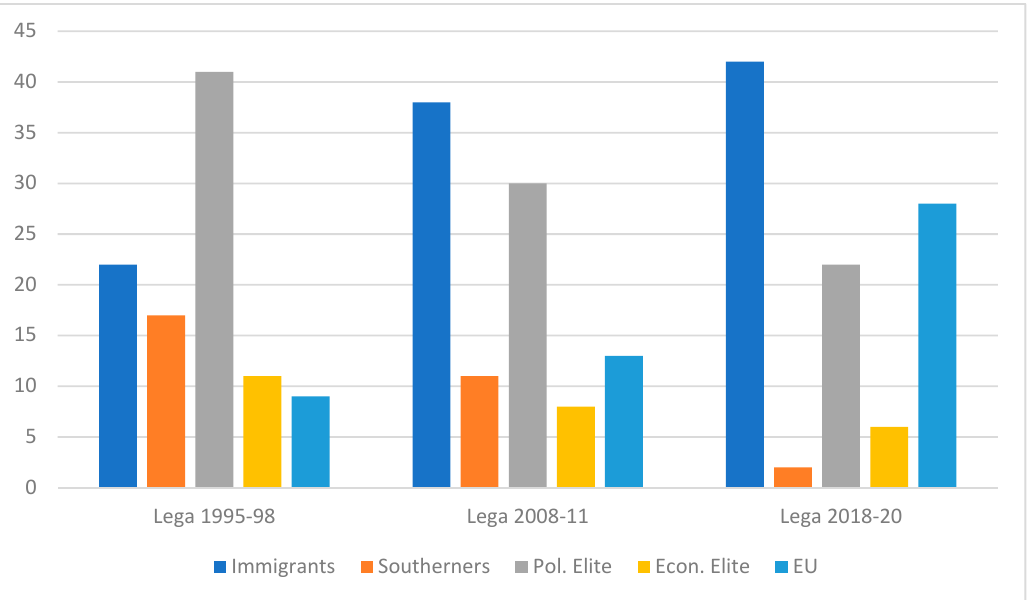
Figure 1. Defining the ‘Other’—the Lega’s framing of the threats to the ‘people’ (in %). It is worth noting that, throughout its transformation from a regionalist actor to a right- The other two components of the Lega’s strategy of demarcating the ‘people’ were a wing nationalist opposition party, the Lega kept the anti-immigrant rhetoric as a constant fea- persistent anti-immigrant rhetoric and an opposition directed at the ‘Southerners’ in Italy. ture in its political mobilization campaigns (Abbondanza and Bailo 2018). From the beginning, Initially, the Lega popularized the nascent notion of a Northern Padania with reference the immigrant has been the politically useful depiction of the ‘Other’ as an interpretative lens to a distinct (and threatening) cultural identity of Southern Italians. From the beginning, to portray the ills of society in terms of a simplistic result of outsiders claiming resources and the Lega combined a welfare chauvinism (pleading to keep resources and taxes in the privileges. In this regard, the Lega employed the political underpinning of exclusionary na- region) with a culturally coded sense of those posing a threat to or being the antithesis of the ‘people’ in ethnically or culturally framed identity terms. Immigrants have always been tionalism in a regionalist context (Mazzoleni and Ruzza 2018). a target of negative campaigning with a view to the alleged drain of resources and threat to a homogenous sense of who the ‘people’ of the North or Padania were supposed to be. Similarly, the focus on the Southerners underlined the notion of a Northern distinctiveness and lingering menace of losing this foundational collective